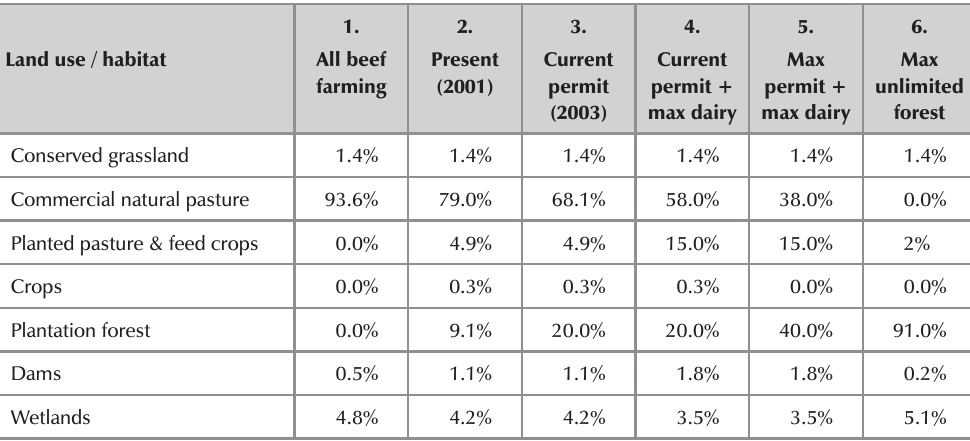
Description of the scenarios used for comparative analysis, giving percentage area of Underberg district (excluding UDP) of different land uses or habitat